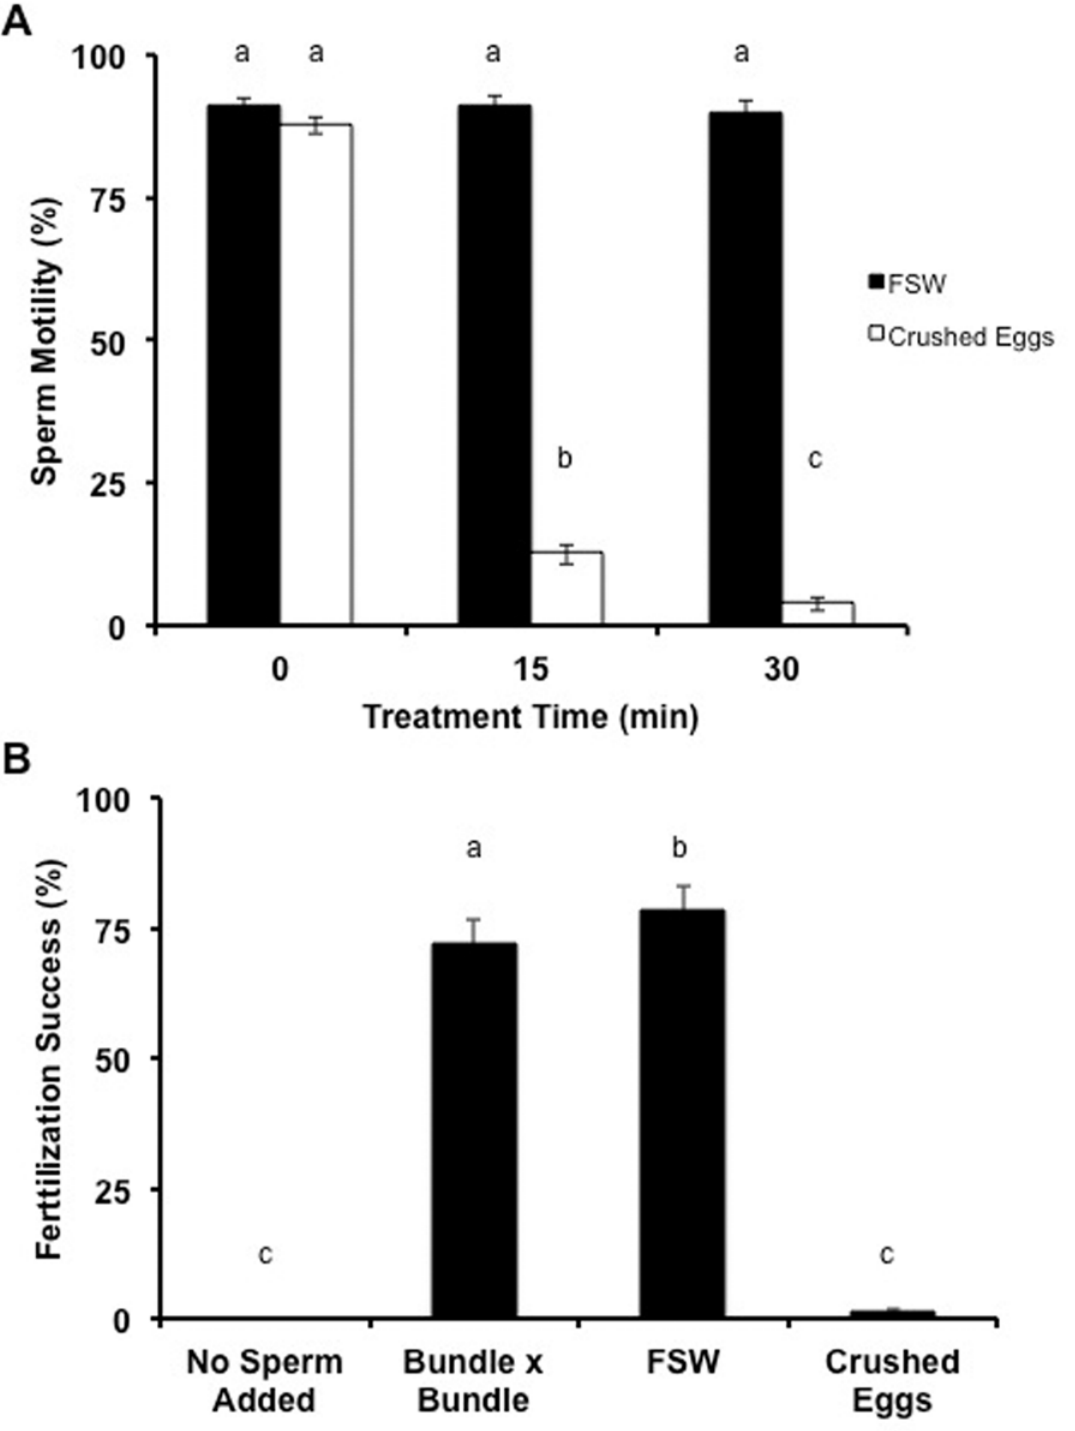
Fig 5. Toxins with the frozen, crushed M . capitata eggs destroyed the tissue and the zooxanthellae of living P . compressa fragments. (A) Only the addition of the caps with the M . capitata eggs caused tissue necrosis. (B, C) Twenty-four h later, only the caps with the M . capitata eggs reduced the quantum yield, indicating that the zooxanthellae in those areas were impaired (P < 0.05). Both the F . scutaria larvae and the M . capitata eggs caused a changed color on the fragment (P < 0.05), but only addition of the M . capitata eggs led to complete tissue necrosis under the cap 6 days later. Bars with the same letter indicate (P > 0.05), but bars with different letters indicate (P < 0.05). Bars indicate